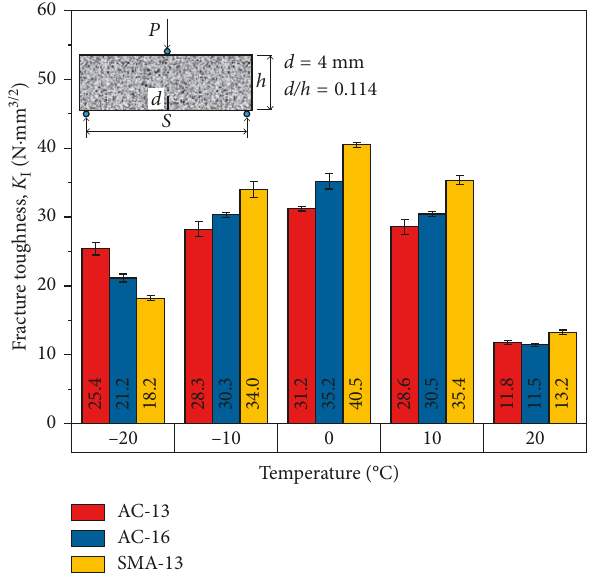
Figure 11: Fracture toughness at different temperatures.